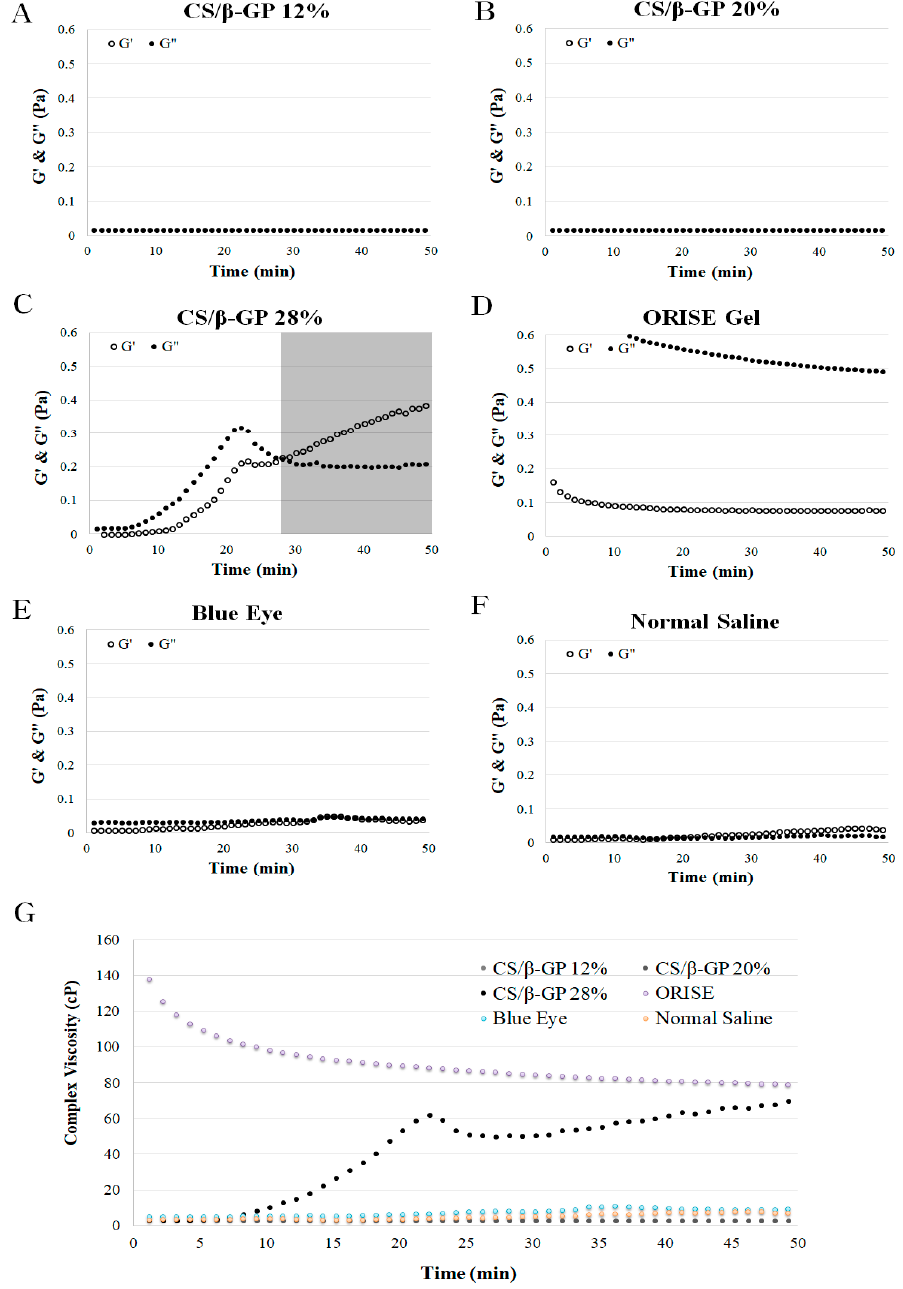
Figure 3. Time dependence of the loss modulus (G (cid:48)(cid:48) , • ) and storage modulus (G (cid:48) , 12%, ( B ) CS/ β -GP 20%, ( C ) CS/ β -GP 28%, ( D ) ORISE™ Gel, ( E ) Blue Eye™, an ( F ) normal saline conditions at 36.5 ◦ C. ( G ) Time dependence of the complex viscosity of all